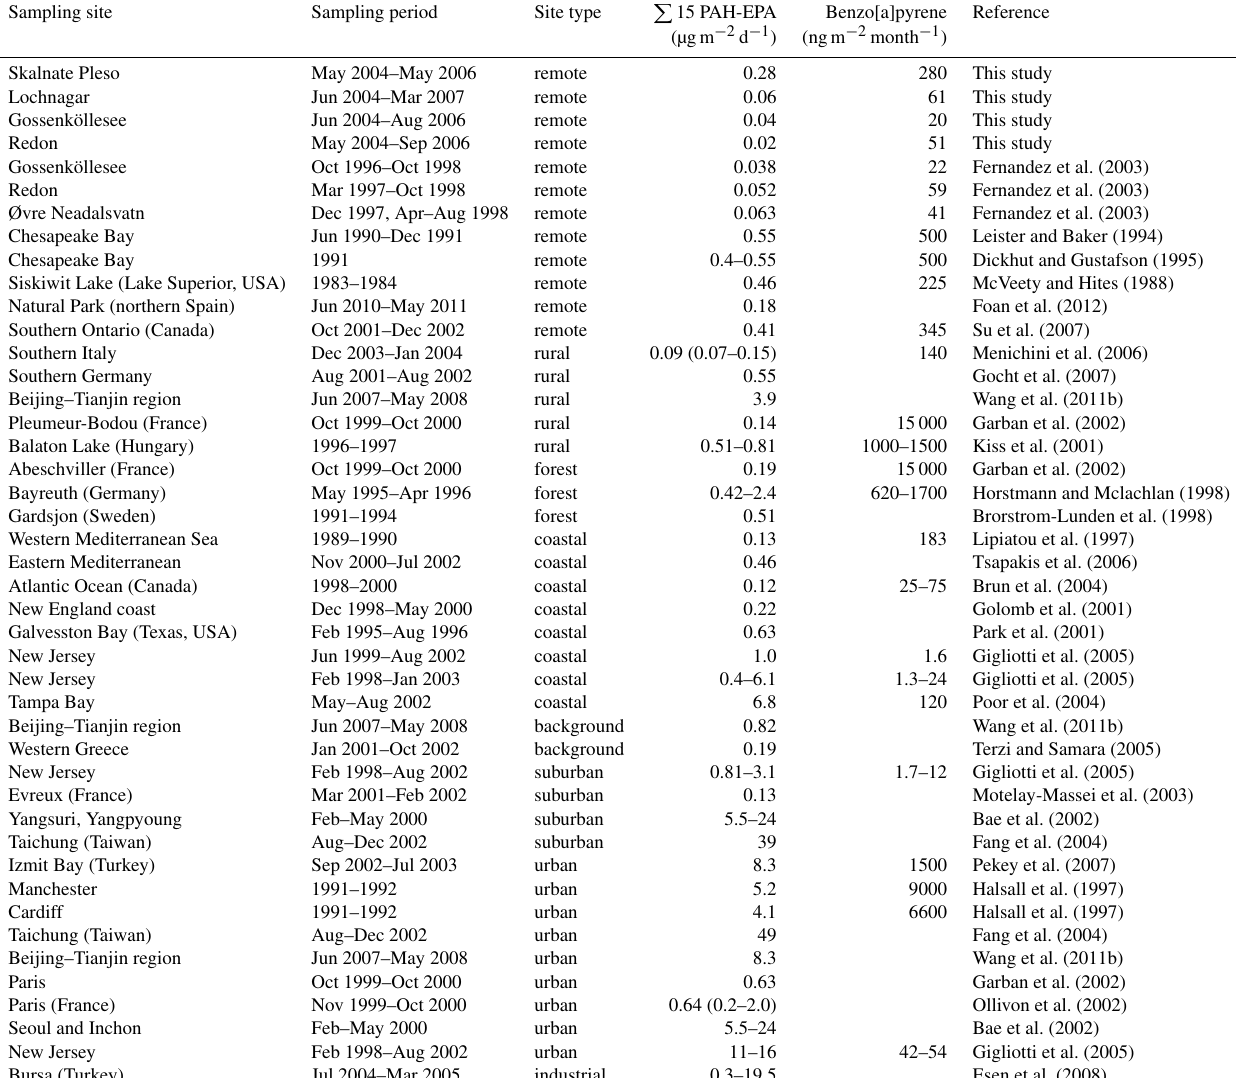
Table 2. Comparison of PAH deposition fluxes with those reported in the literature. Sampling